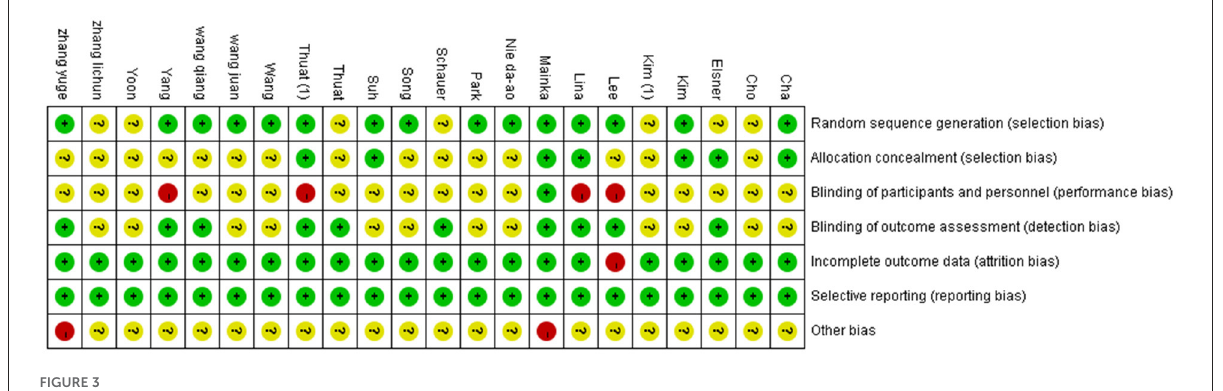
FIGURE3 Risk of bias